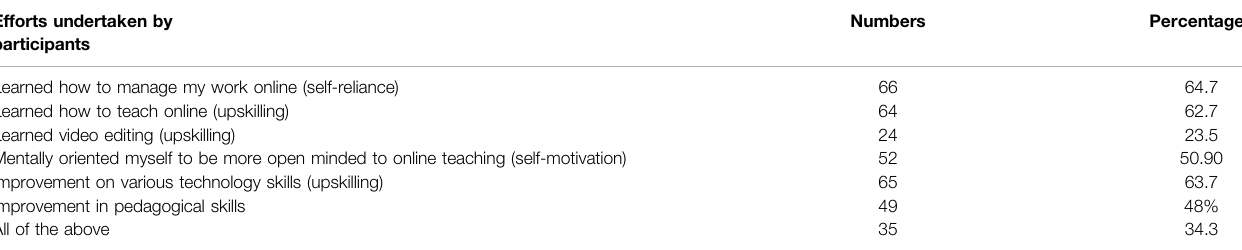
TABLE 6 | Percentage improvement in techno-pedagogical skills as a result of remote teaching and learning in a Covid-19 pandemic. Efforts undertaken by